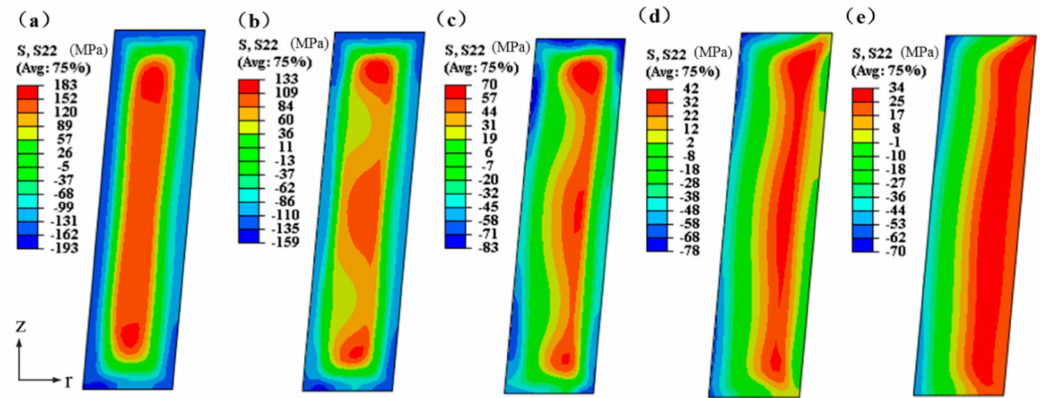
Figure 8. Residual stresses nephogram of the 2A14 tapered cylinder forging in the t-direction under different cold bulging ratio conditions: ( a ) 0%; ( b ) 1.0%; ( c ) 2.0%; ( d ) 3.0%; and ( e ) 4.0%.